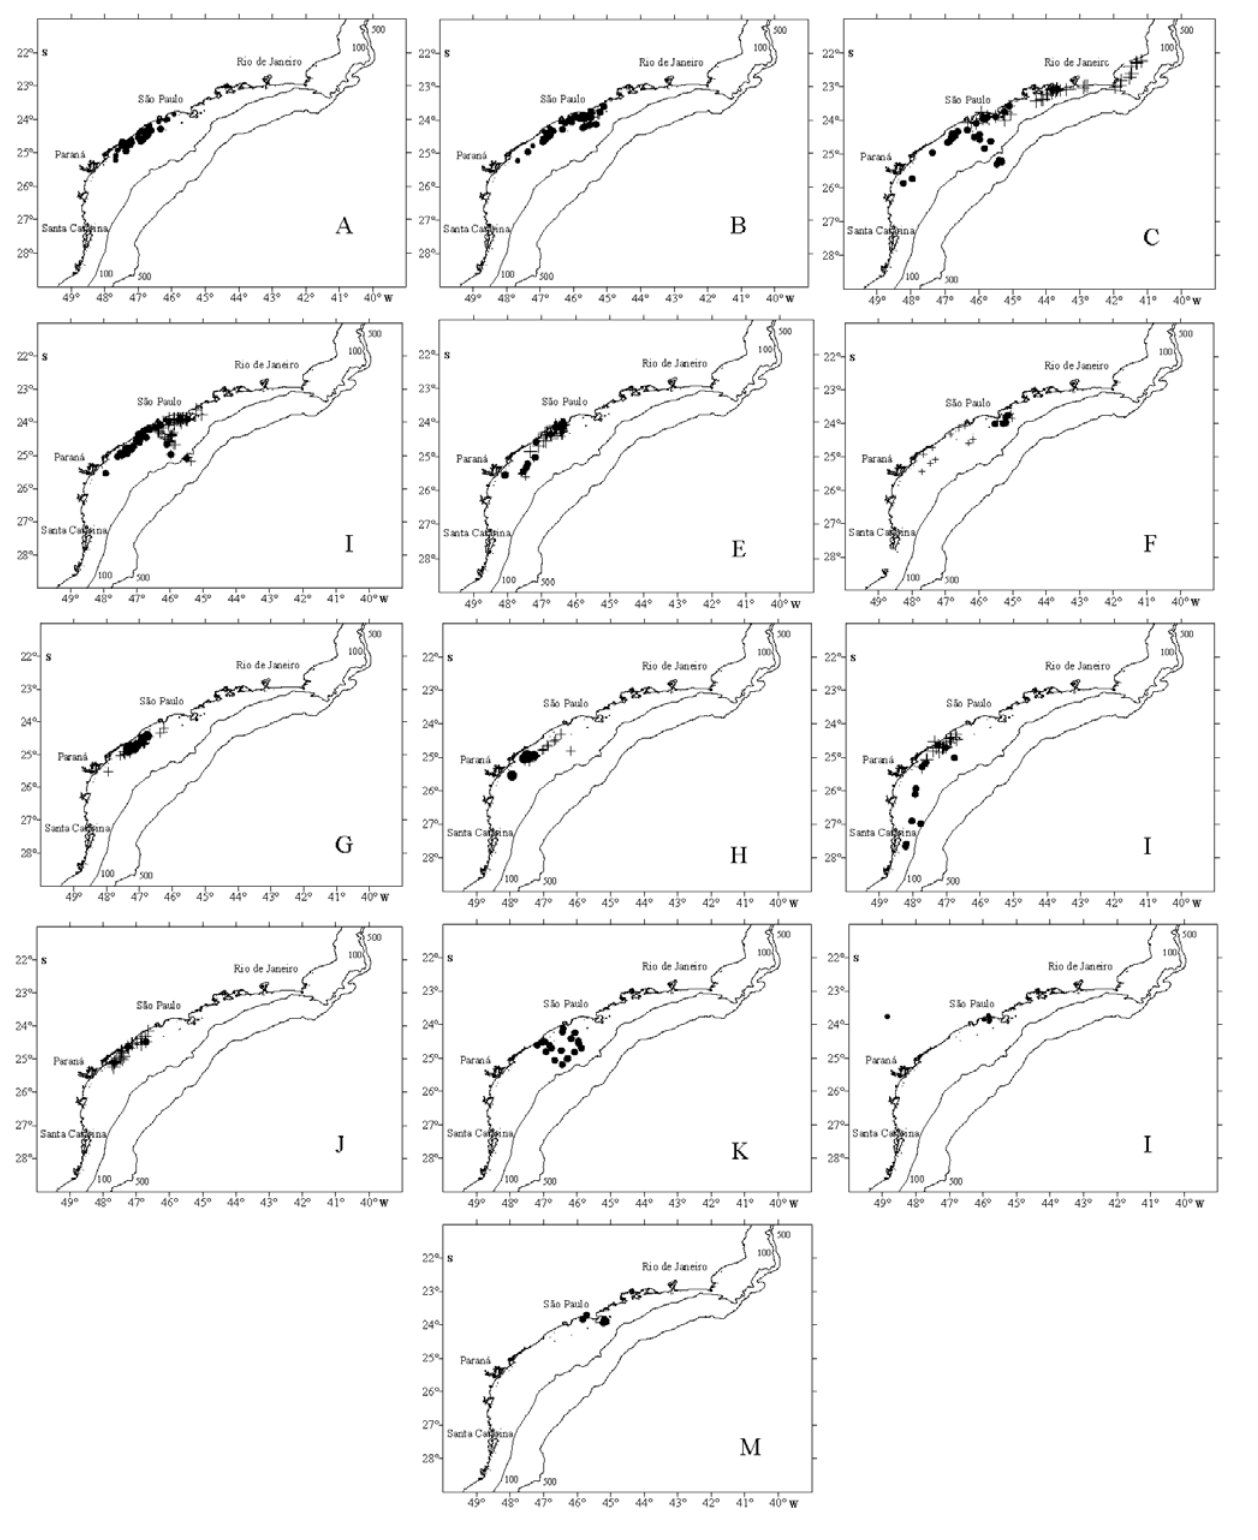
Fig. 2. Maps of Southeast Brazil, showing the fishing hauls by month, conducted by a total of eight fishing vessels. Symbols represent the fishing hauls from where samples of Rioraja agassizi were collected (dotted circles), or when this information was not available, the total hauls recorded by the skippers